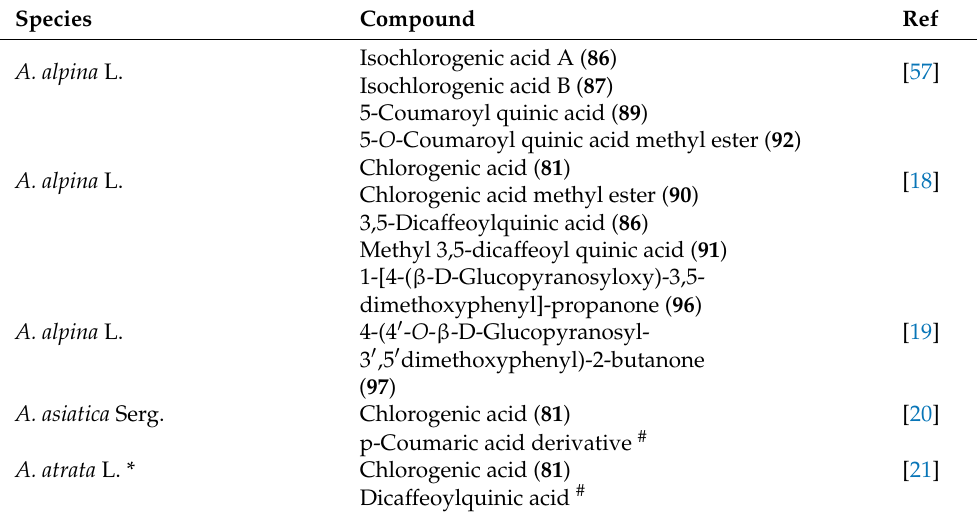
Table 5. Phenolic and quinic acids from Achillea